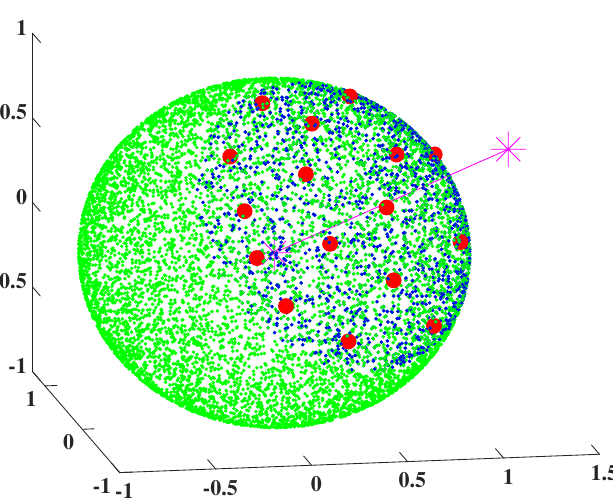
Figure 2. Codebook for conditional RVQ generated by the LBG algorithm. In Figure 2, green and blue dots mean unselected and selected vectors by a specific condition, respectively. The codebook is generated from the selected vectors. The red dots mean the vectors of the codebook. The generated codebook of Figure 2 is calculated in the conditional vector space that the angle between the purple vector and the arbitrary green vector is lower than π . 3 Algorithm 2 details generation of a codebook for the sparse vectors. In Algorithm